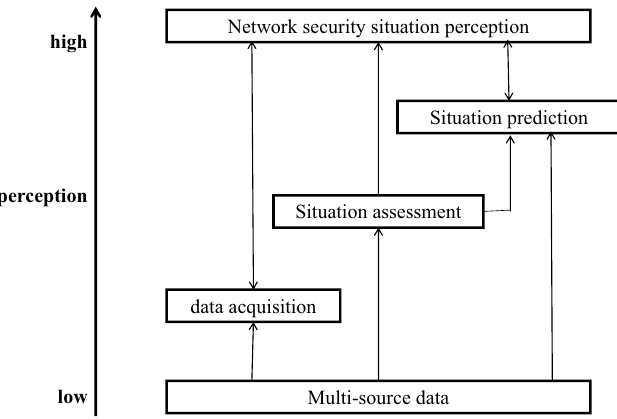
Figure 3: Network security situational awareness